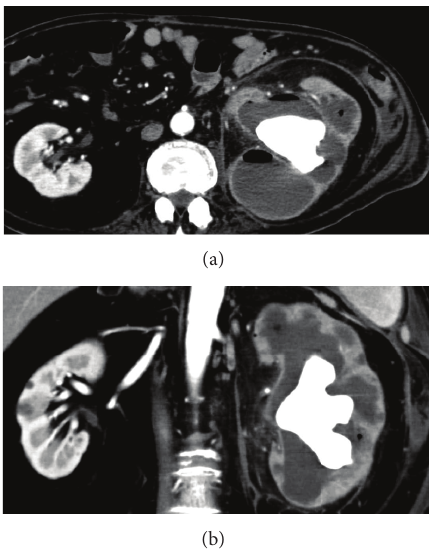
F 1: CT �ndings of the abdomen ((a) transverse section and (b) coronal section) CT showed an enlarged nonfunctioning le kidneyandstaghorncalculi,withdistentionofthecollectingsystem.